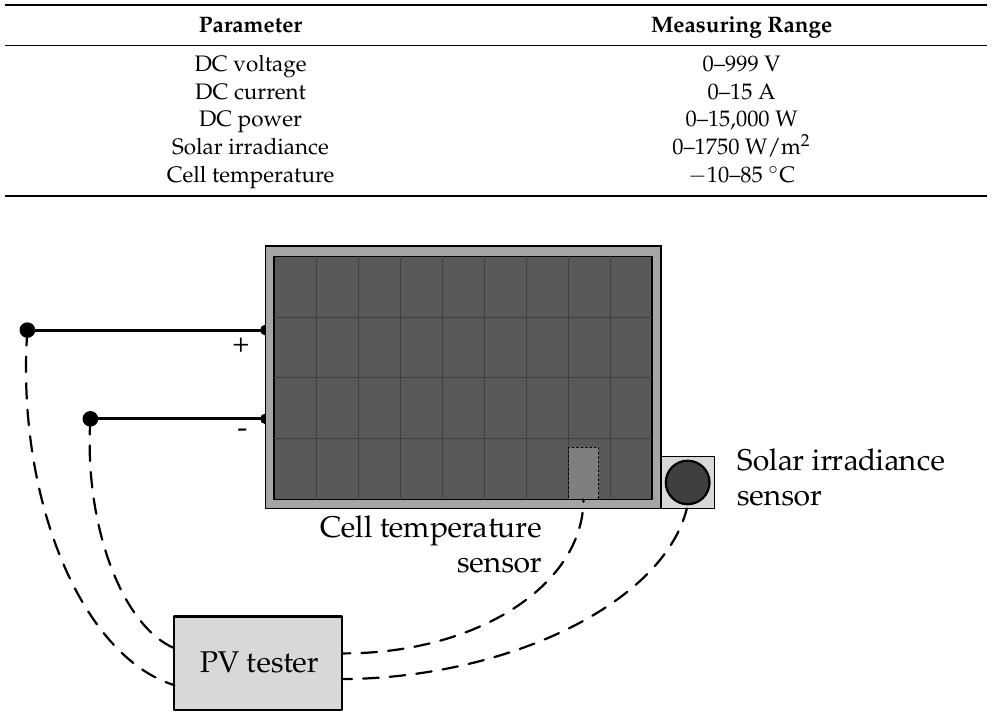
Figure 14. PV module I-V curve measurement procedure with the PV tester. PV module I-V curve measurements are given for 2 out of 13 PV modules with no visible damage to the glass surface. The environmental conditions at the moment of I-V curve measurement for both PV modules are given in Table 9. Table 9. Environmental conditions at the moment of the I-V curve measurements. PV Module No.